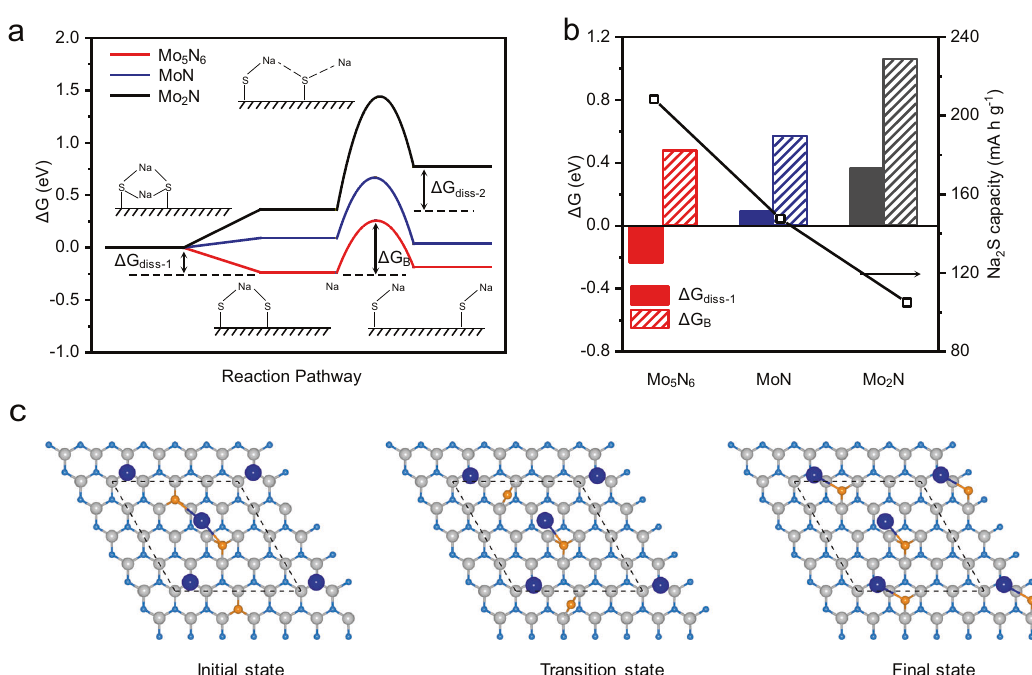
Fig. 5 Computational investigation of Na 2 S electrodeposition. a Gibbs free energy diagram of conversion from Na 2 S 2 to NaS* on the three surfaces including adsorption of Na 2 S 2 , dissociation of Na 2 S 2 to form adsorbed NaS 2 (NaS 2 (cid:1) ) and formation of adsorbed NaS (NaS * ) from the NaS 2 * . Δ G diss-1 is dissociation free energy of Na 2 S 2 . Δ G diss-2 indicates formation free energy of NaS (cid:1) , and Δ G B indicates NaS * formation free energy barrier. b Relationship between computed Δ G diss-1 or Δ G B values and measured electrodeposition capacities on the three molybdenum nitrides surfaces. c Atomic con fi gurations for NaS* formation step on the surface of Mo 5 N 6 . The gray-color, light blue, orange, and blue spheres represent Mo, N, S, and Na atoms,